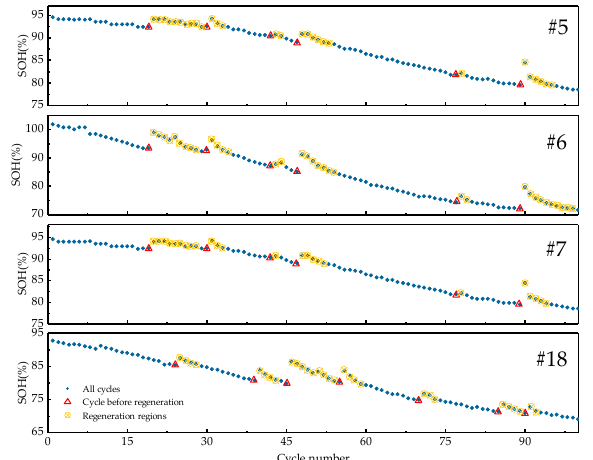
Figure 6. The extraction of normal degradation and capacity regeneration.